Question: Write the caption for this figure.
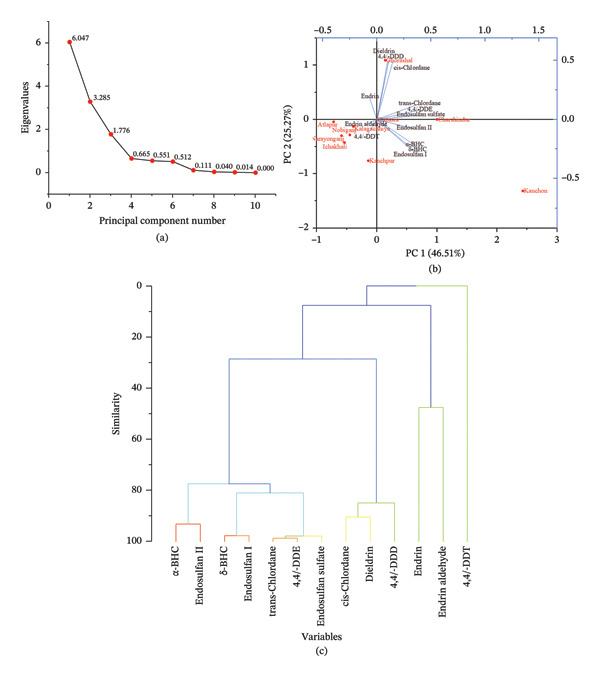
Answer: Scree plot (a), biplot of PCA (b), and cluster analysis (c) of the spatial dataset of OCPs.